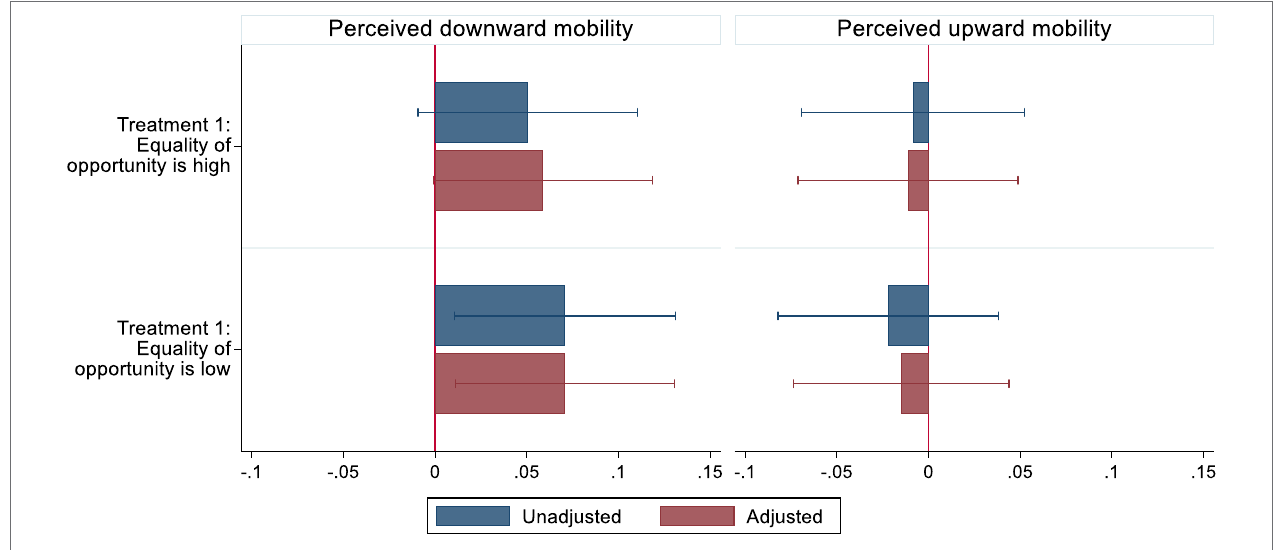
FIGURE 2 | Effect of information about (in)equality of opportunity on the perception of being downwardly and upwardly mobile. Point estimates (with 95% confidence intervals) give the absolute difference between the treatment groups and control group in the proportion of respondents who perceived being downwardly or upwardly mobile when prompted that equality of opportunity is high (T1) or that equality of opportunity is low (T2). Adjusted linear probability models account for respondents’ age, gender, parental education, own education, material deprivation index, unemployment status, settlement type, number of children, IDP status, and the fixed effects for the interview date.